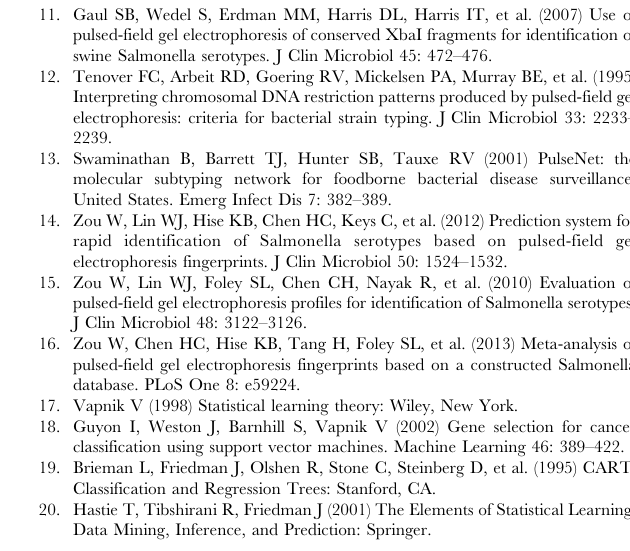
prediction model for the test dataset of 1,000 simulated samples. Table values are the averages over 1,000 repetitions. Table S2 Upper panel. Frequency distributions of classification patterns identified by the DLDA composite model (m1, m2, m3, m4) for the synthetic training dataset consisting of 4 subgroups, S1, S2, S3, and S4. Lower panel. Performance of the DLDA composite prediction model for the test dataset of 1,000 simulated samples. Table values are the averages over 1,000 repetitions. Table S3 Frequency distributions of classification patterns identified by the RF composite model (m 1 –m 10 ) for the Salmonella PFGE training dataset consisting of five serotypes. Sixteen classification patterns are identified; 13 of the 16 have frequencies of at least 5 (last column). The last two rows show the sensitivity and specificity of the model performance. Table S4 Frequency distributions of subgroup patterns identi- fied by the RF composite model for the Salmonella PFGE test dataset, which consisted of 5,055 isolates from five training serotypes and 1,000 additional ‘‘Decoy’’ isolates. The serotypes I4,[5],12:i-, Hadar, Oranienburg, Thompson, Typhimurium, and Decoy were labeled as A, B, C, D, E, and F, respectively. n is the number of isolates in the serotypes. Fourteen of 24 identified classification patterns had frequencies at least 5. The last two rows show the sensitivity and specificity of the model